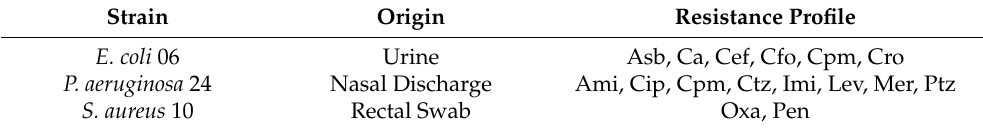
Strain Origin Resistance Profile E. coli 06